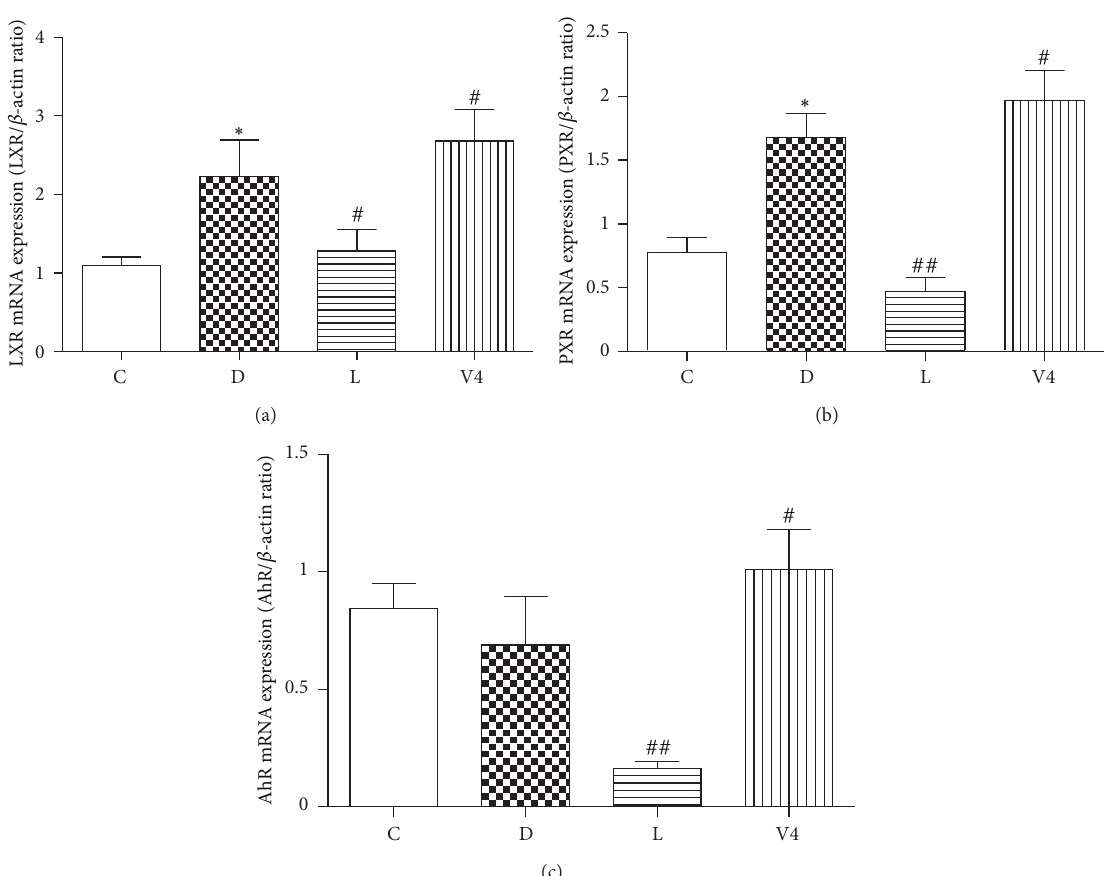
Figure 5: Effects of V 4 dipic-Cl on mRNA expression levels of LXR , PXR, and AhR . C: Control group, D: Diabetic group, L: H 2 dipic-Cl-treated group, V4: V 4 dipic-Cl-treated group. Values are expressed as mean ± SEM, 𝑛 = 3 . ∗ 𝑃 < 0.05 versus C. # 𝑃 < 0.05 versus D, ## 𝑃 < 0.01 versus